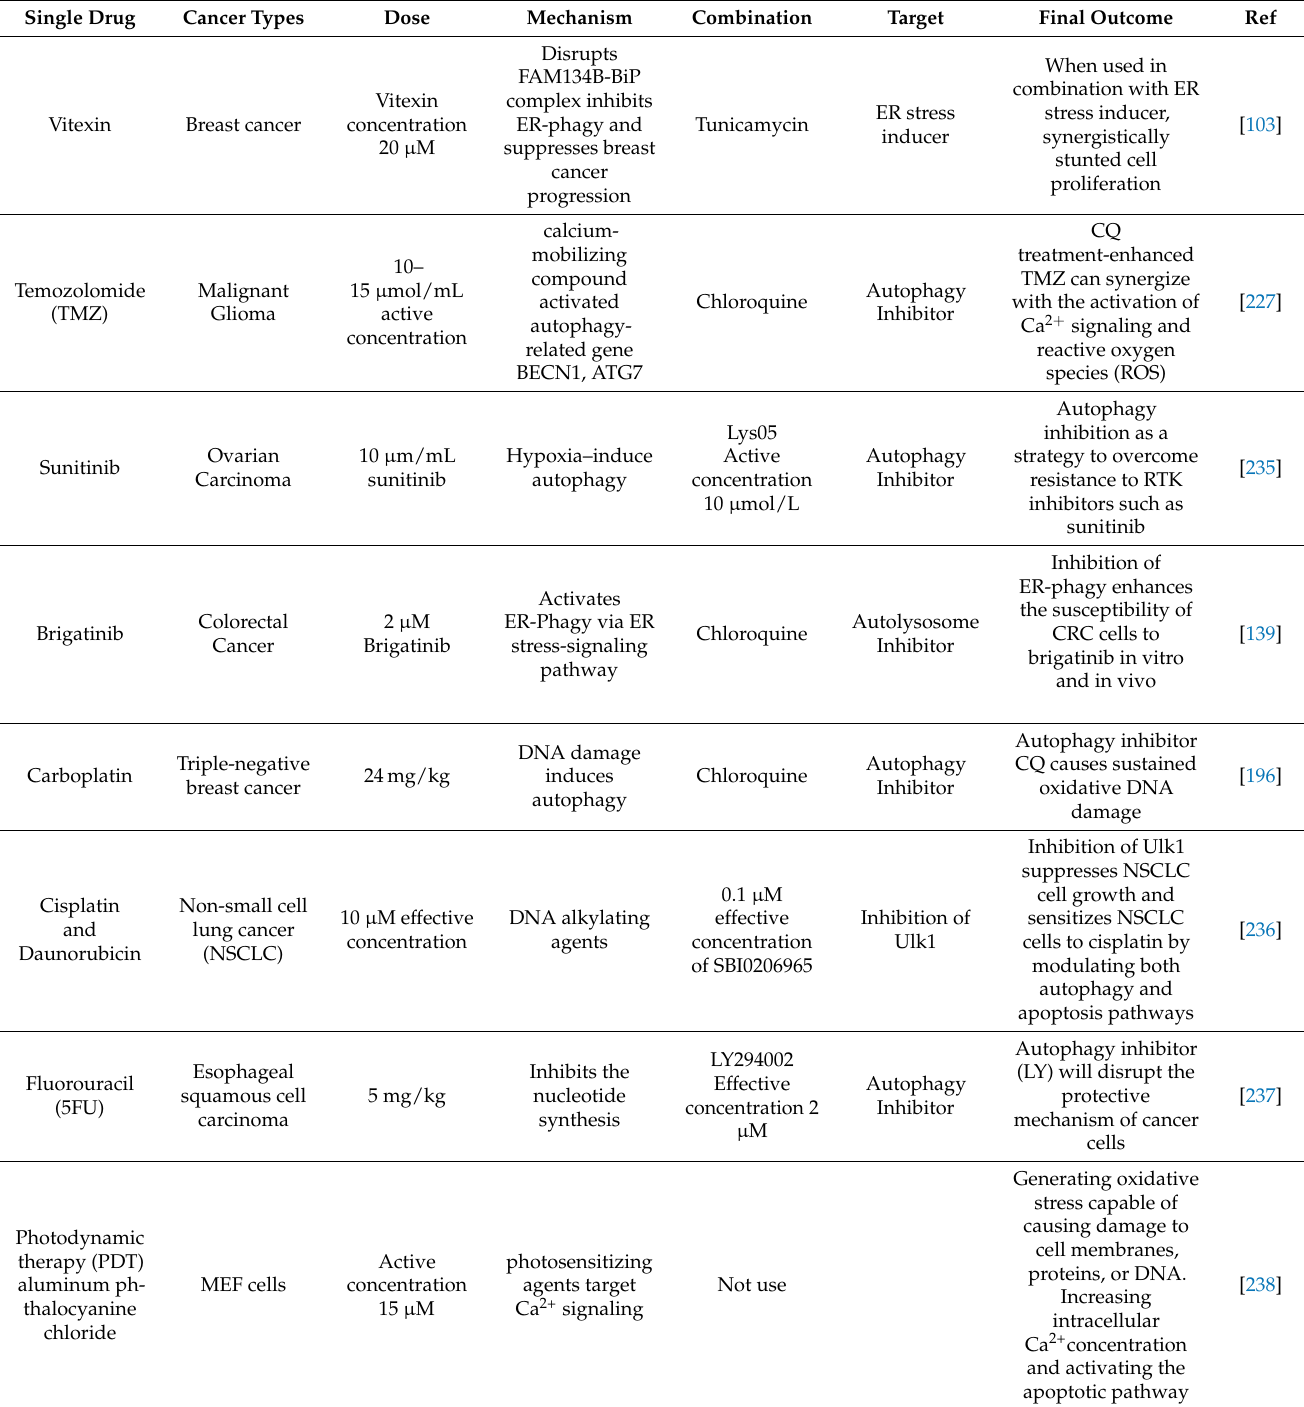
Table 4. Efficacy of ER stress inducer and autophagy inhibitors in cancer